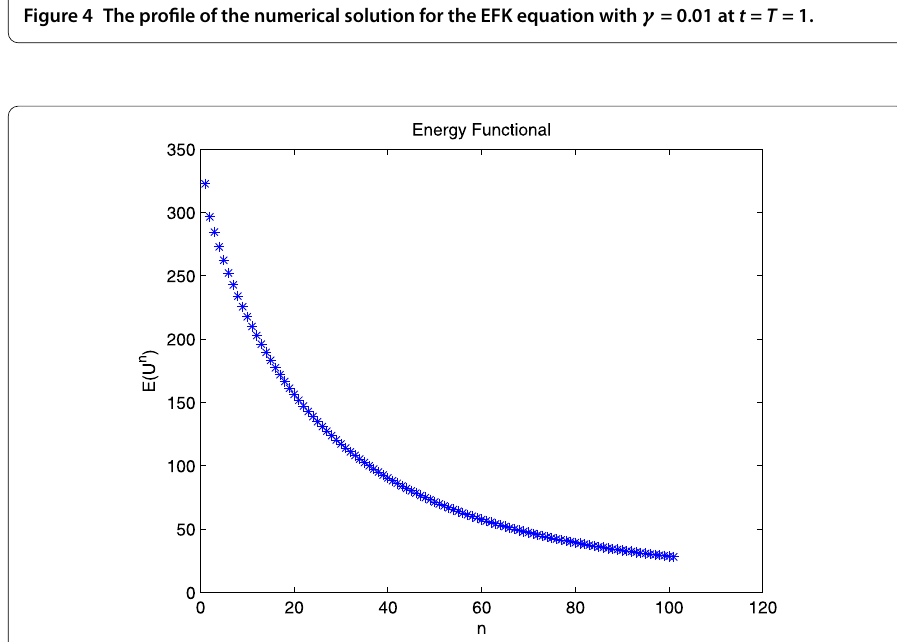
Figure 5 The profile of the Lyapunov functional with γ = 0.01 at n =